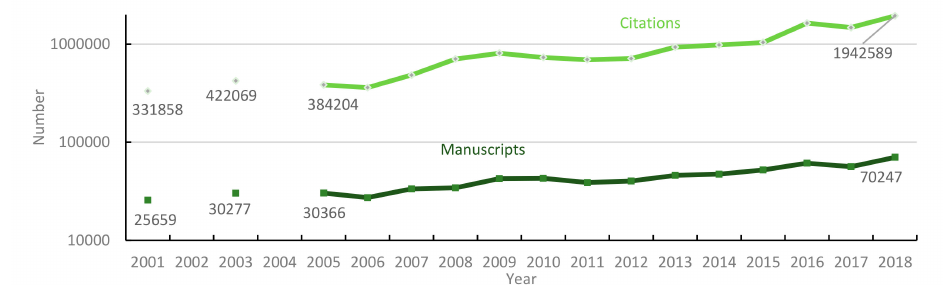
Figure 2. Evolution of citations and articles in the category Engineering, Electrical and